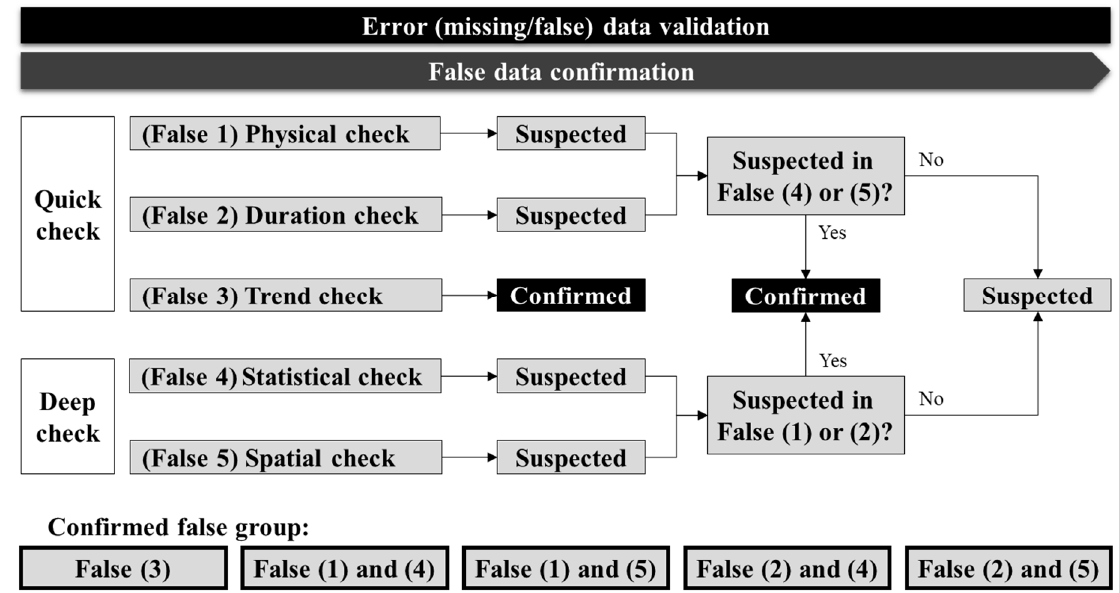
Figure 3. Process for suspected and confirmed false data categorization.